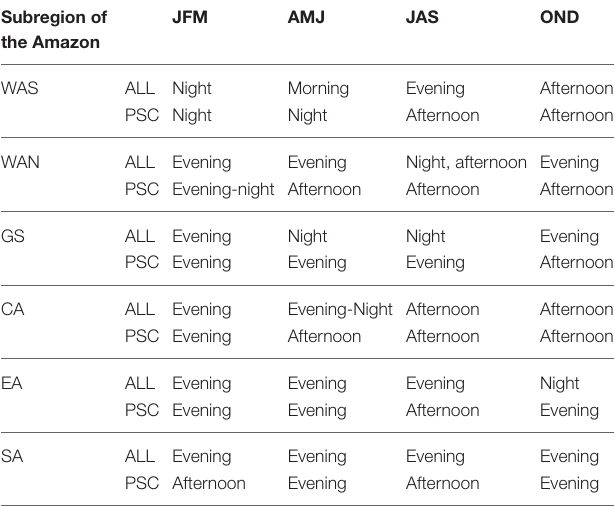
TABLE 5 | Time of day of maximum in the number of PSC for each subregion and each quarter: night (0000–0600 LT), morning (0600–1200 LT), afternoon (1200–1800 LT), and evening (1800–2400